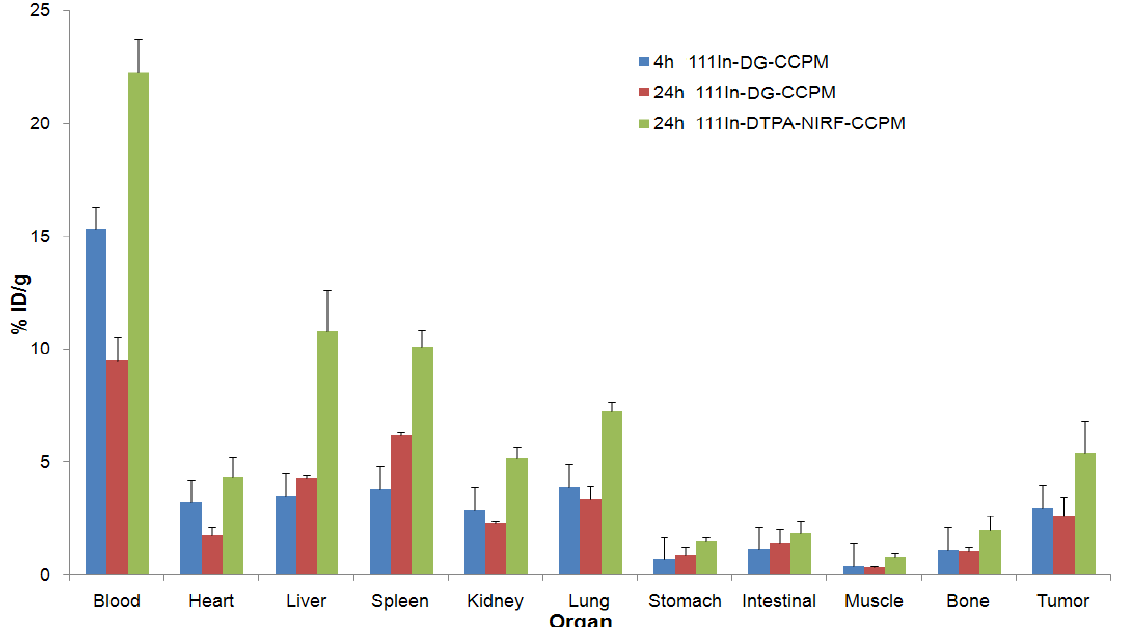
Figure 4. Biodistribution studies of 111 In labeled CCPM in nude mice bearing A 431 tumors at 4 h and 24 h.